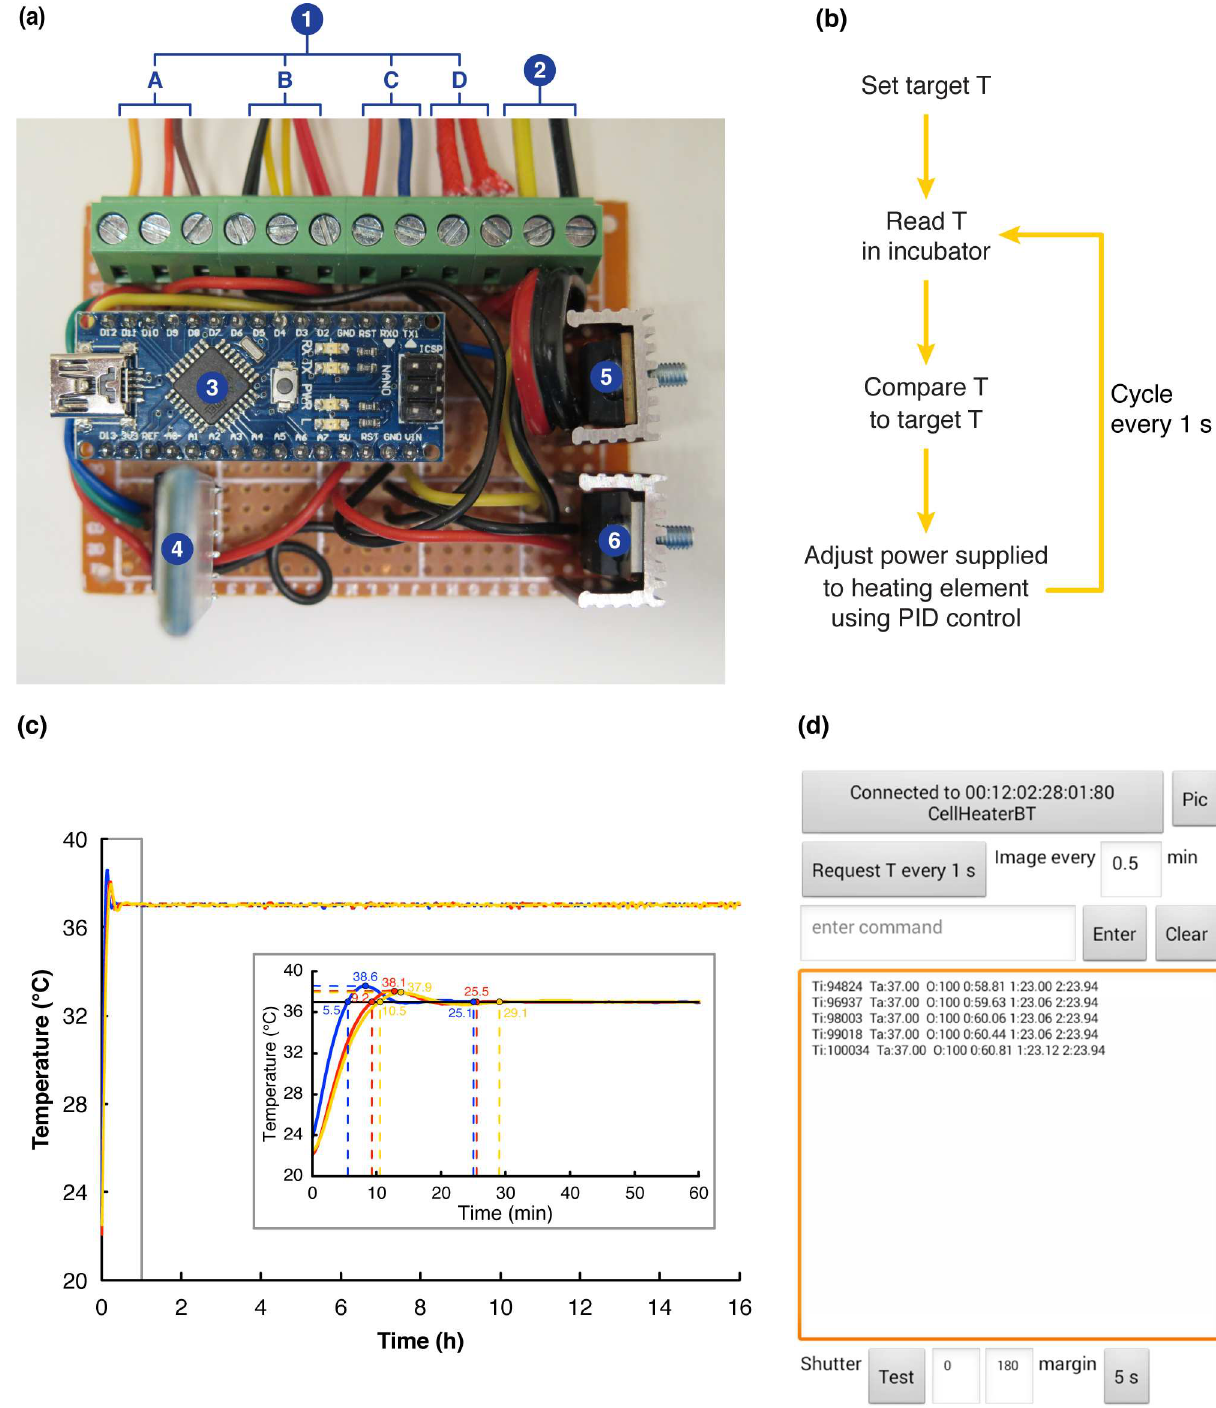
Fig 4. The control unit and the ATLIS Control app. (a) Photographof the ATLIS control unit. (1) The power outlets for the shutter’s servomotor (A), the temperature sensors (B), the fan (C), and the heatingelement(D) are indicated.(2) Power supply to the control unit. (3) ArduinoNano 3.0 ATmega328 microcontroller. (4) Bluetooth communication module. (5) Power transistor for heatingelementcontrol. (6) Voltage regulator. (b) Overview of the temperaturecontrol loop. The temperature inside the incubatorwas continuously monitored by a sensor and comparedto the target temperature in order to adjust the power suppliedto the heatingelement. (c) Temperature curves for three independent experiments showingthe temperature inside the incubatorduringa 16 h period. Inset (gray box): magnification of the